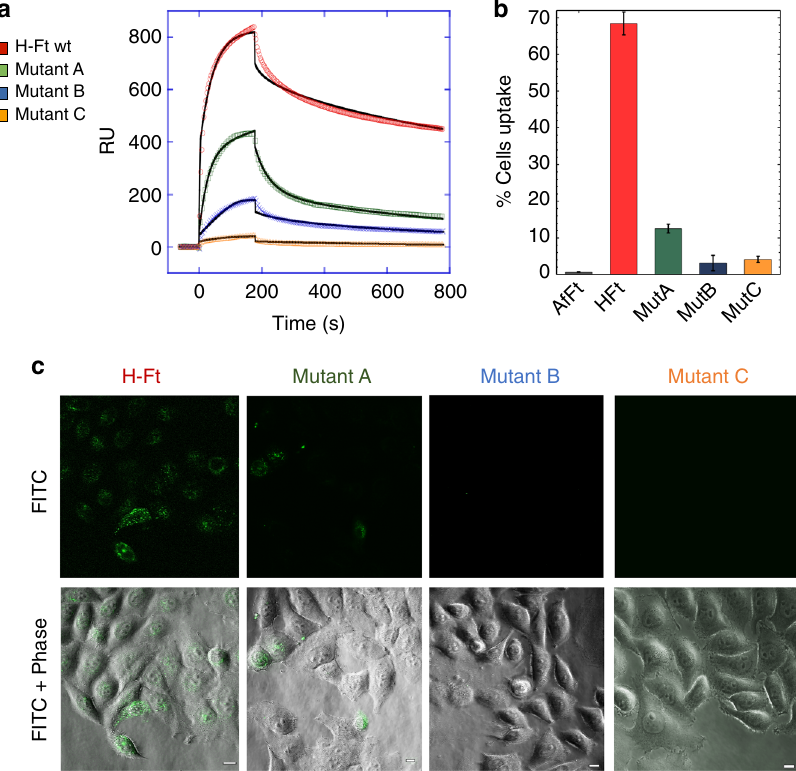
Fig. 3 Characterization of human H-Ft wild type and mutants binding to CD71. a SPR sensograms of the interaction between the immobilized his-tagged CD71 receptor and H-Fts (wild-type and mutants), used as analytes. Fits are reported as black lines. Source data are provided as a Source Data fi le. b Ferritins uptake in HeLa cells has been quanti fi ed by fl ow cytometry. The percentage of cells internalizing AfFt-FITC (here used as negative control 19 ), H-Ft- FITC, MutA-FITC, MutB-FITC, and MutC-FITC is shown as mean ± s.e.m. for n = 3 independent experiments. Source data are provided as a Source Data fi le. c Internalization of ferritins in HeLa cells observed at a ×60 confocal microscope, here shown as single FITC and overlay images with phase-contrast. Scale bars: 10 µ